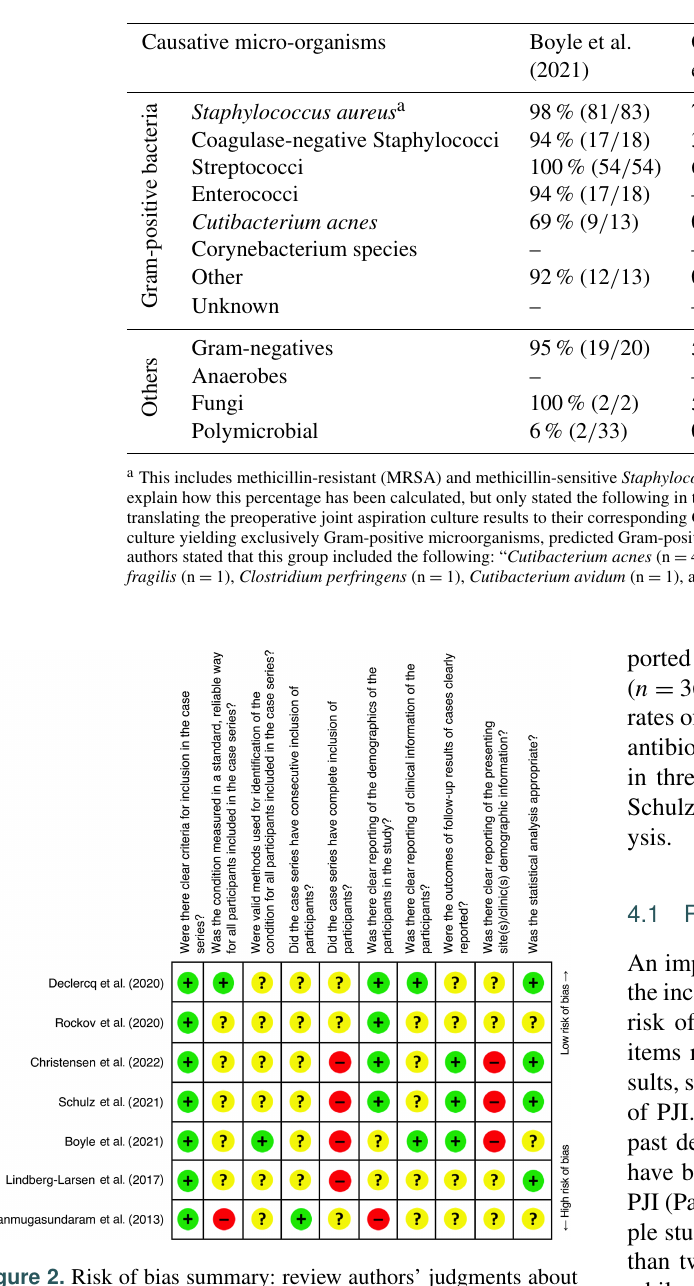
Table 2. Concordance rates of specific causative micro-organisms.